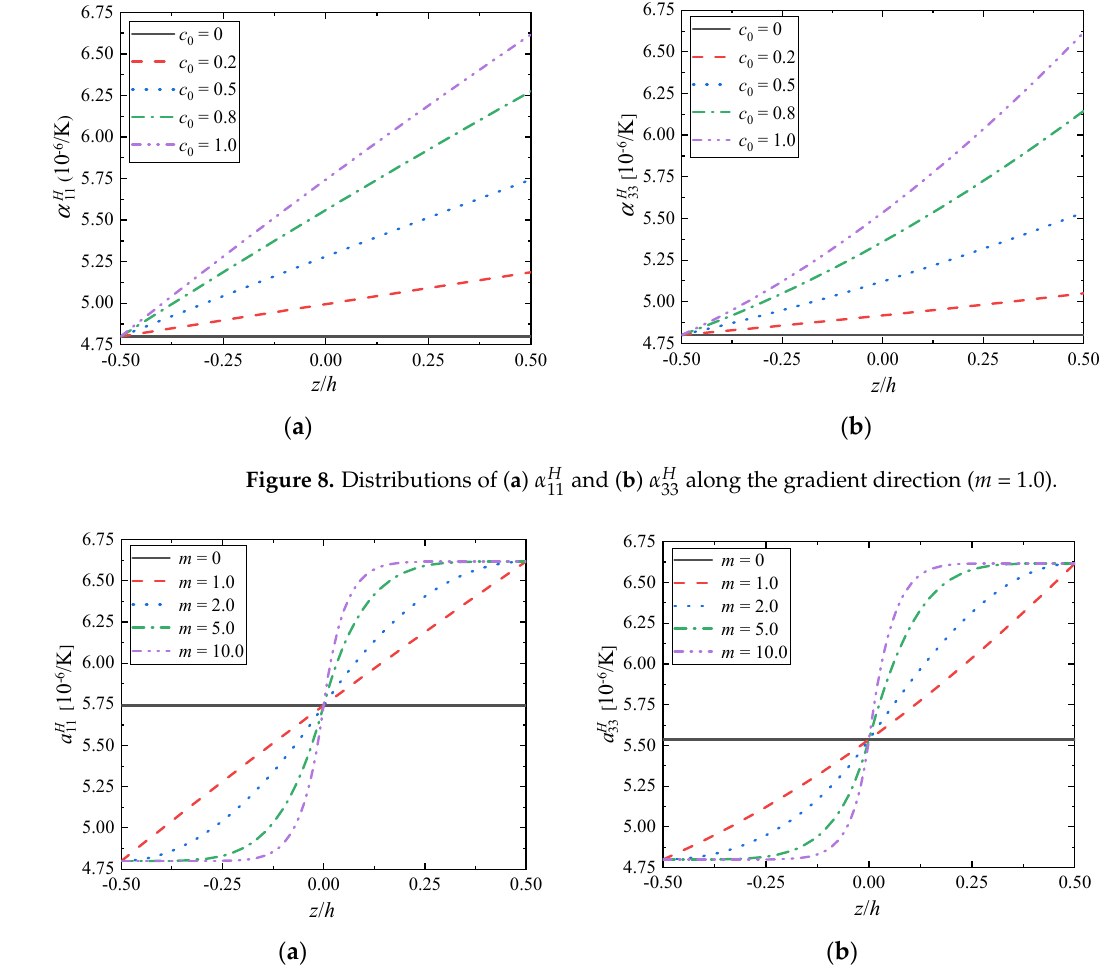
Figure 9. Distributions of ( a ) 𝛼